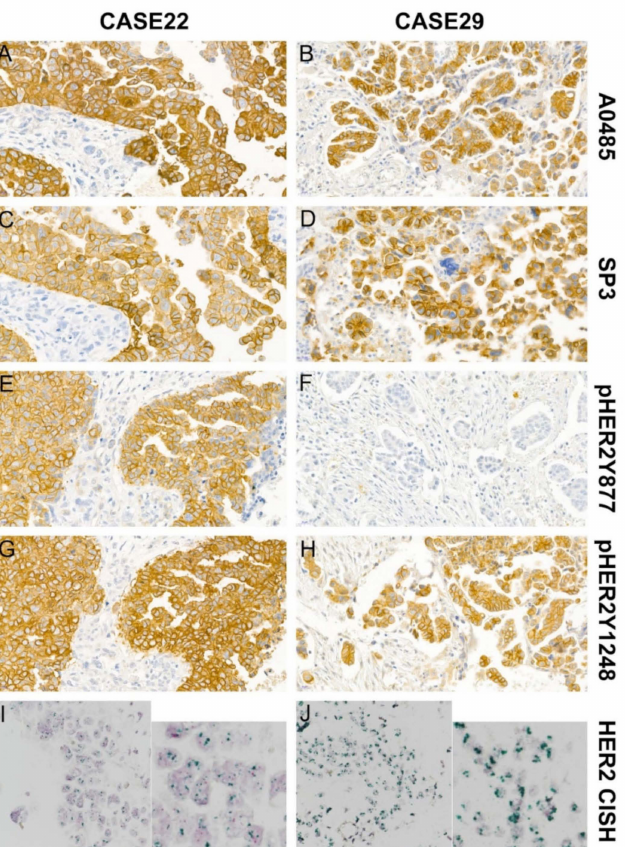
Figure 2. HER2 CISH and HER2 immunohistochemical staining in peritoneal disseminated cancer cells of HGSOC using four anti-HER2 antibodies: A0485, SP3, pHER2Y 877 , and pHER2Y 1248 ( A – J ). Cases 22 and 29 showed positive HER2 amplification ( I , J ). Original magnification, 600 × . Case 22 shows positive HER2 expression using all four anti-HER2 antibodies ( A , C , E , G ), and case 29 was positive using three antibodies (A0485, SP3, and pHER2Y 1248 ) ( B , D , H ). Original magnification, 400 × . Table 2. Correlations among positivity in the four HER2 assays. A0485 Matched Pairs Negative (26 cases) Positive (12